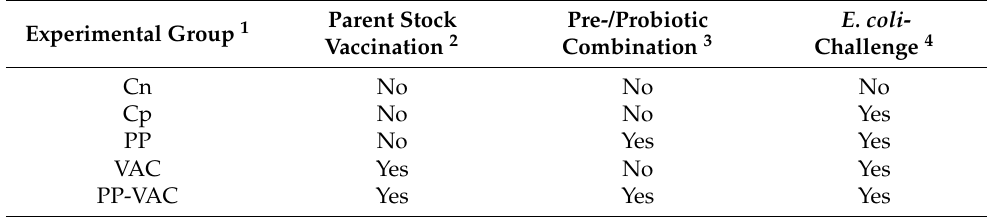
Table 5. Experimental setup to test preventive strategies (pre-/probiotic combination and parent stock vaccination) in an Escherichia coli challenge model with growing Ross 308